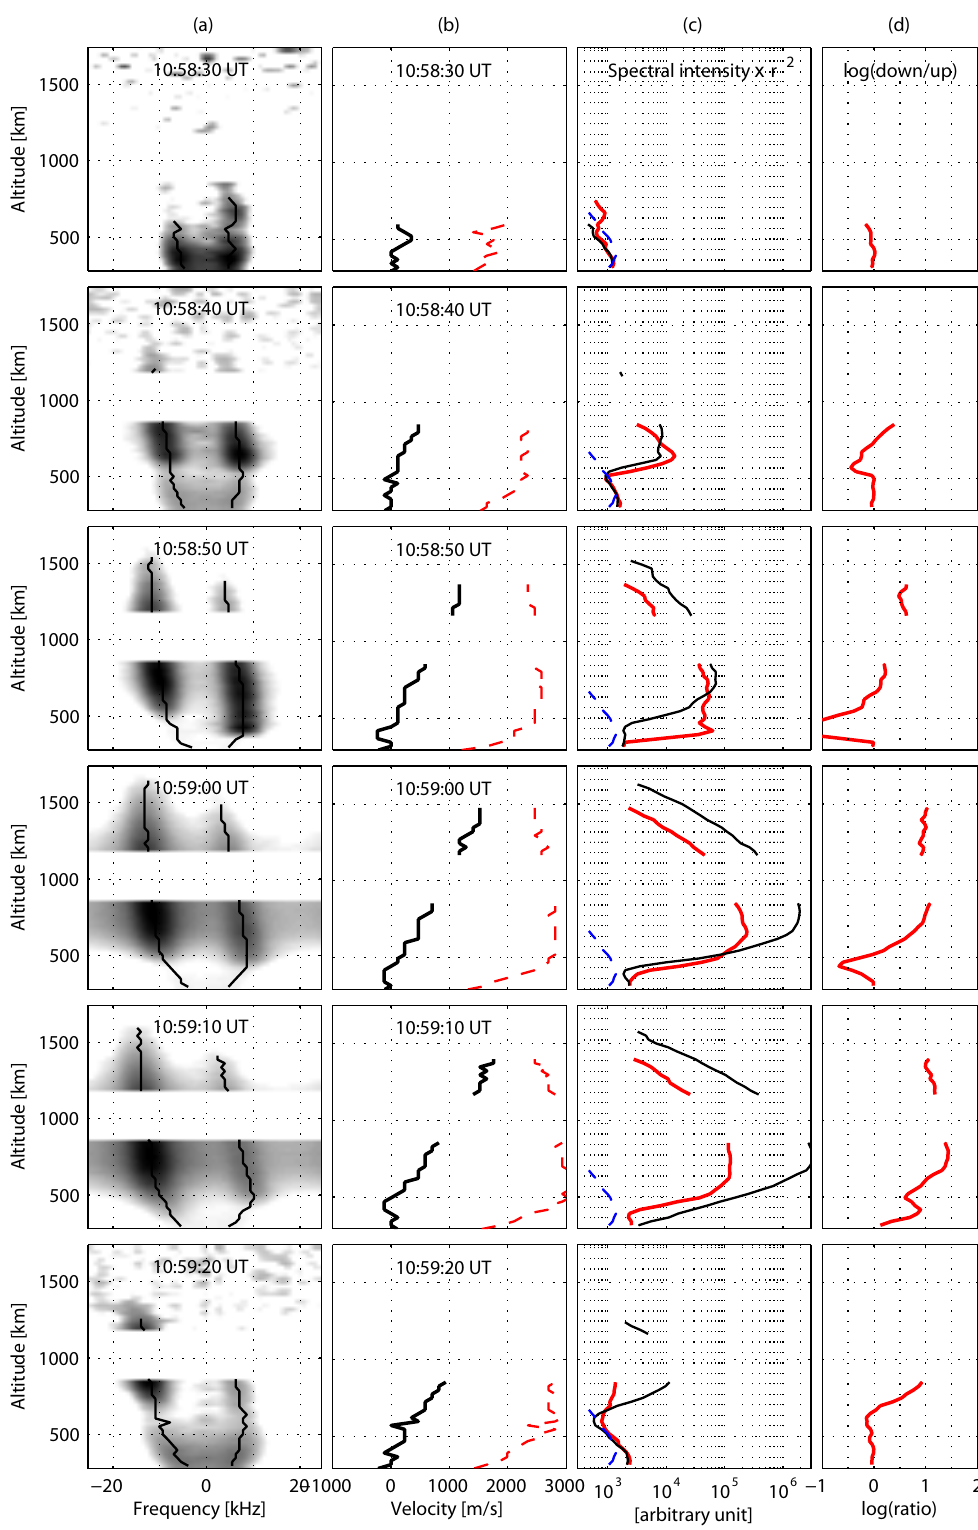
Fig. 6. Fig. 6. (a) IS spectra, gray coded, between 10:58:30 and 10:59:30 UT on 28 July 2000. (b) Doppler velocity (black lines) and ion-acoustic speed (red dashed lines). (c) Peak power of upgoing (black) and downgoing (red) ion-acoustic lines. Normal IS signals (blue dashed line) at 10:20:10 UT are added to each plot. (d) The ratio of the downshifted to the upshifted peak.